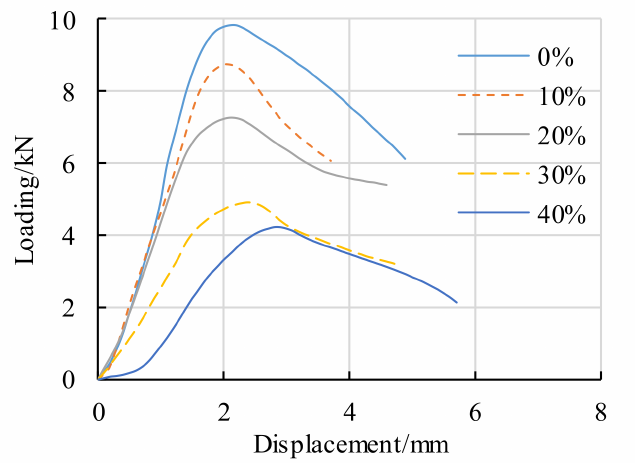
Figure 4. Loading to displacement curves of uniaxial compression